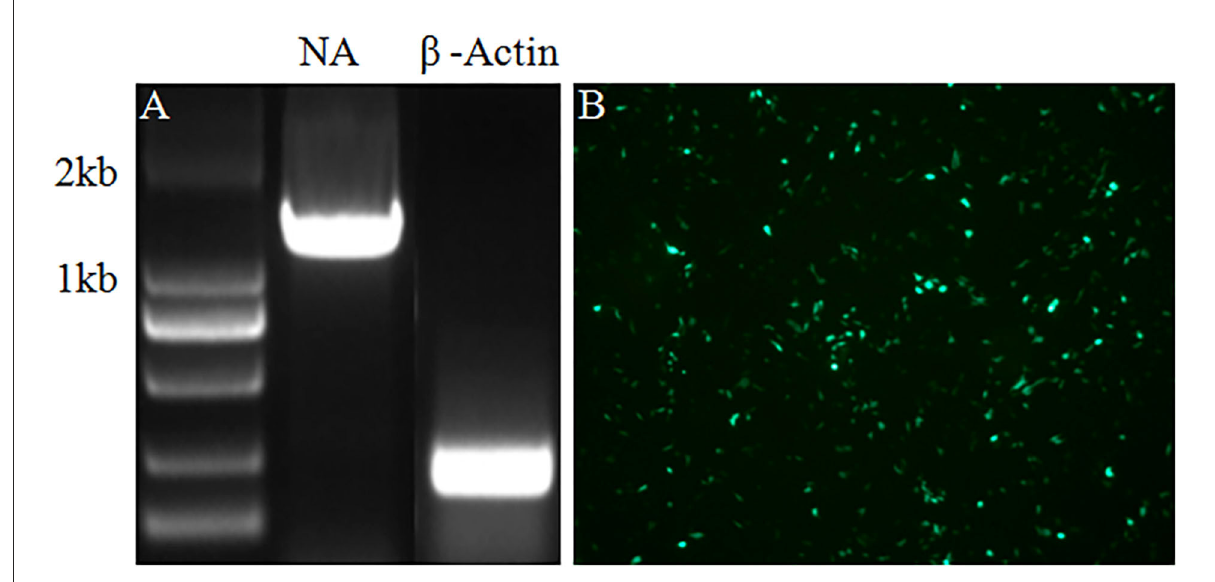
FIGURE1 RT-PCR and IFA were performed to verify the integration and expression of the NA in MDCK cells stably expressing NA protein. (A) The NA gene was amplified by RT-PCR with mRNA of β -Actin as internal control. (B) Expression of the NA protein was tested by